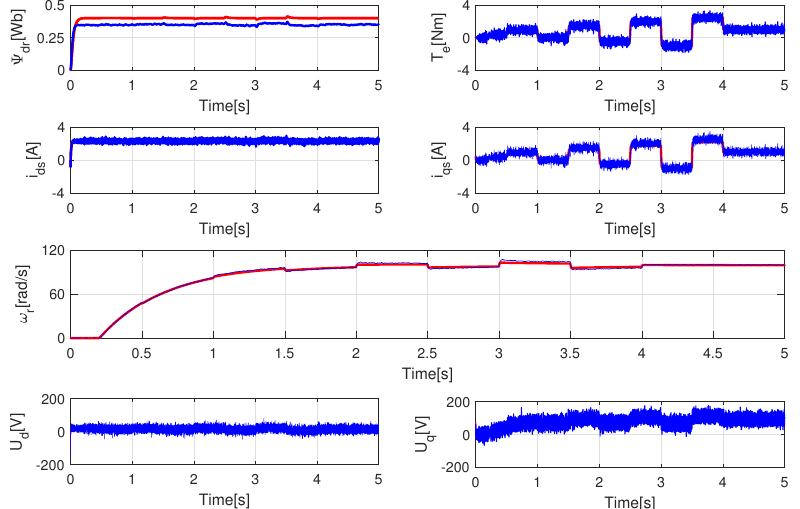
Figure 11. Case 2, parameter uncertainty test compared to ideal condition. Red curves with nominal parameters, blue ones with